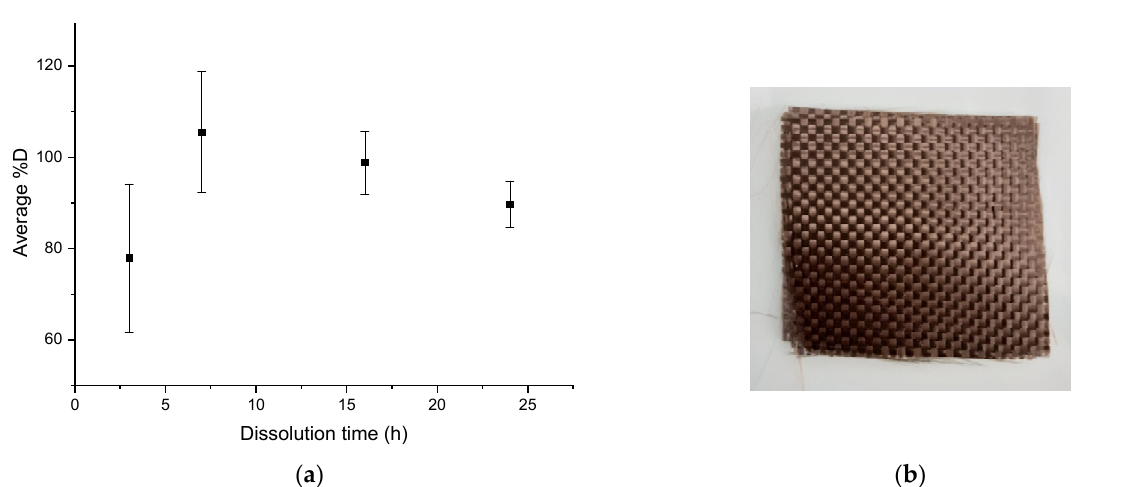
Figure 8. ( a ) Evolution of the average % D as a function of dissolution time for mechanical stirring for a ratio of 1:40, ( b ) Fabrics obtained after the complete dissolution.